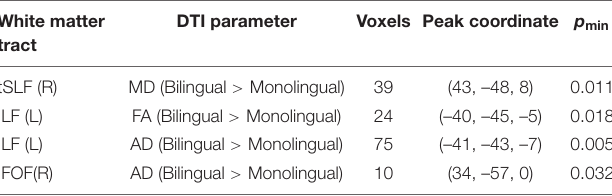
TABLE 2 | Results of the tract-specific TBSS